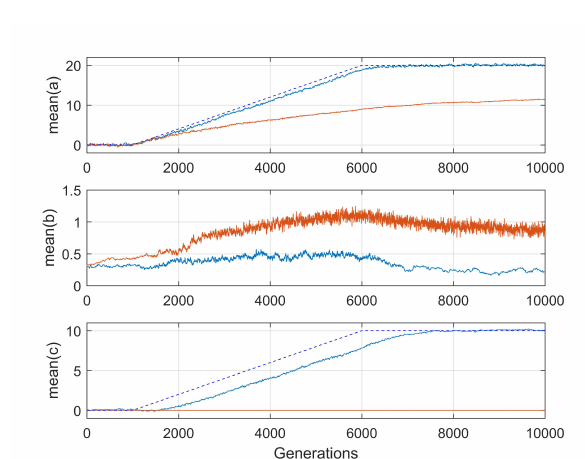
Figure 6: Ramp responses for the system in Subsec- tion 4.1, with G cc = 0 . 5 (blue) and G cc = 0 (magenta). The input values of µ U and µ Θ are also shown (dashed).